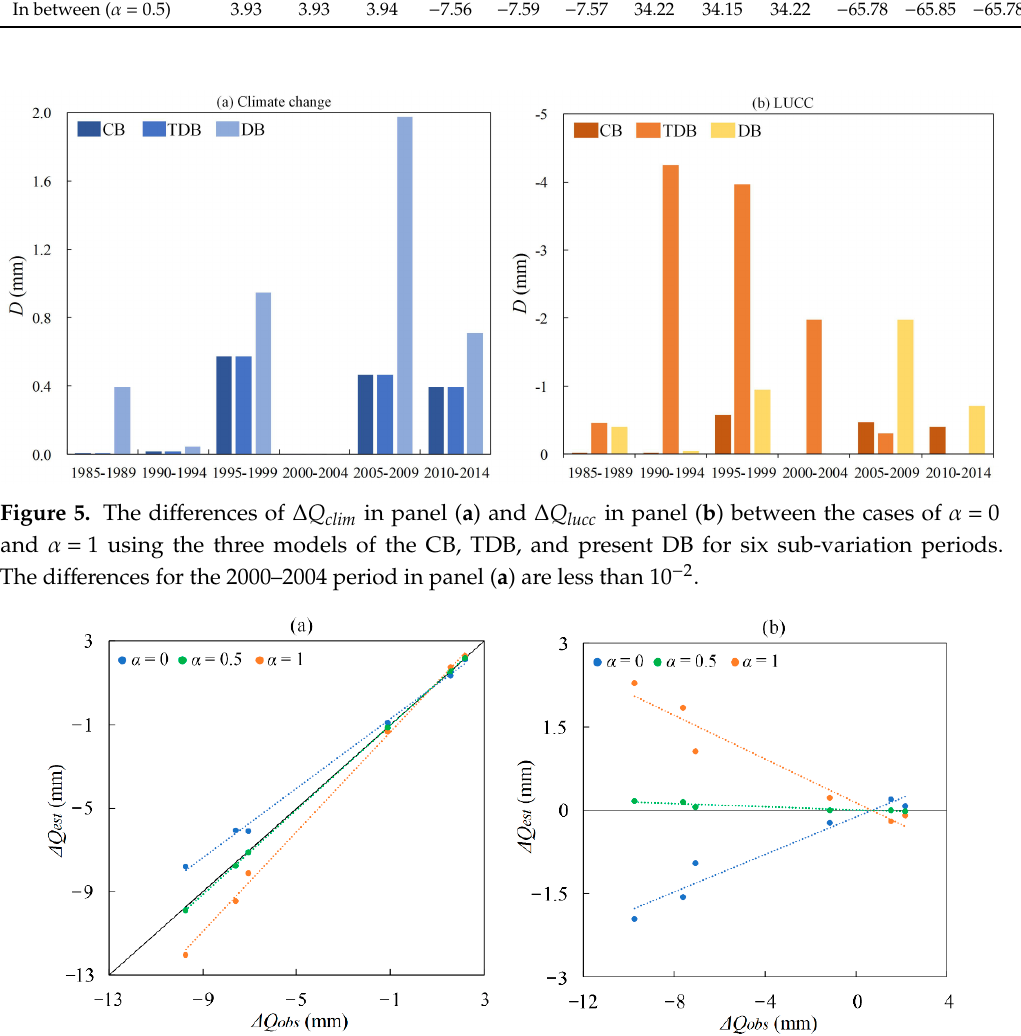
Figure 6. ( a ) Comparison of ∆ Q est with ∆ Q obs , ( b ) the relation of ∆ Q res and ∆ Q obs for each of six sub-variation periods estimated by the TDB model for three cases of α = 0 for the lower boundary, α = 1 for the upper boundary, and α = 0.5 in between.